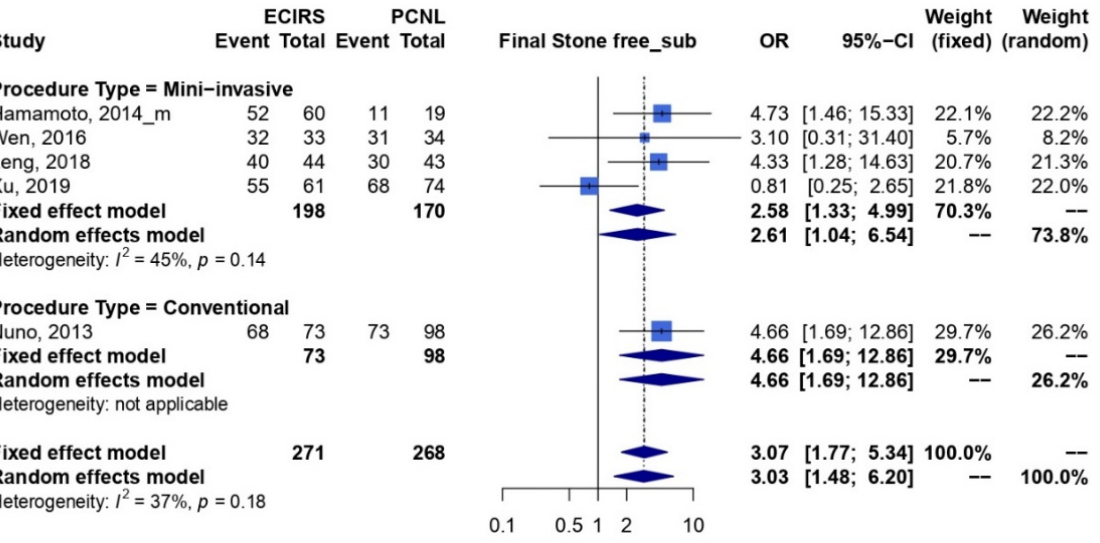
Figure A2. Subgroup analysis of outcome regarding final stone free rate. (Mini: [17][19][22,23]; Conventional: [20])